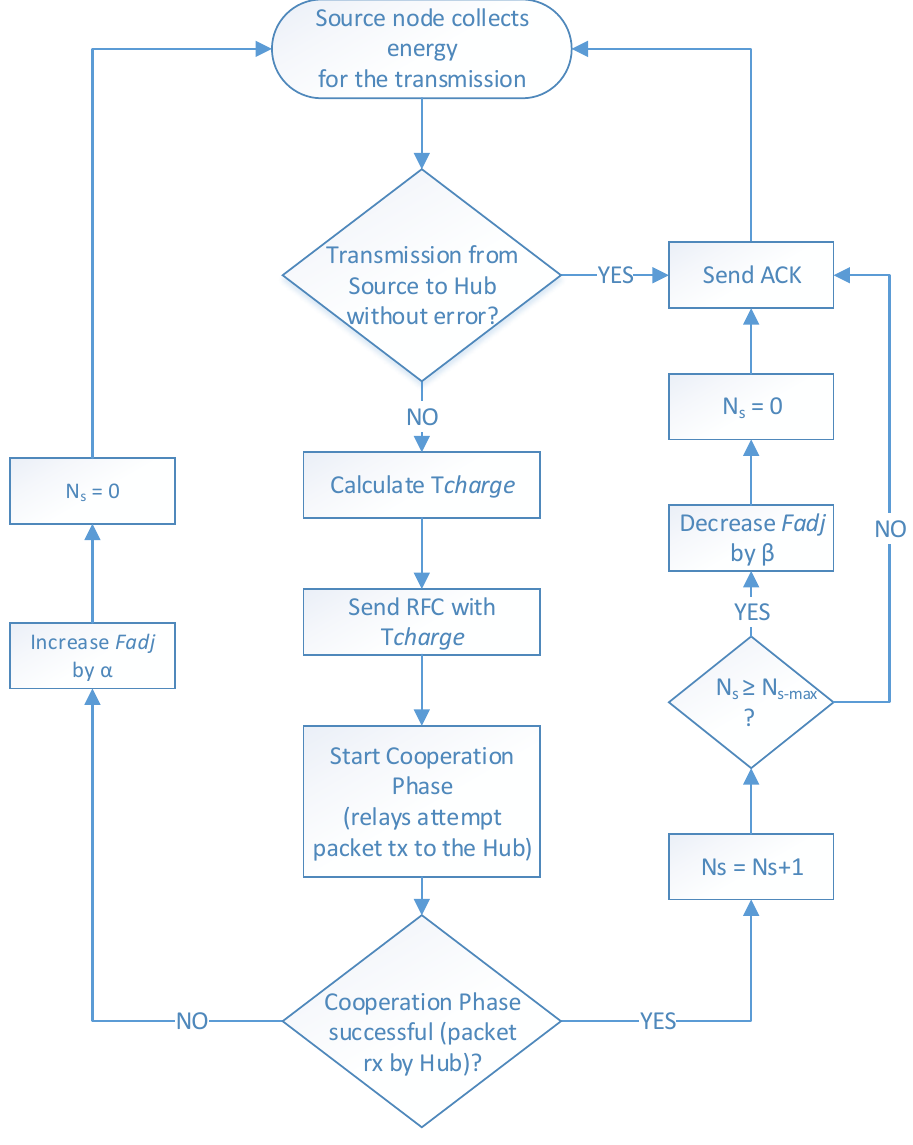
Figure 2. Cooperative energy harvesting (CEH)-MAC operation